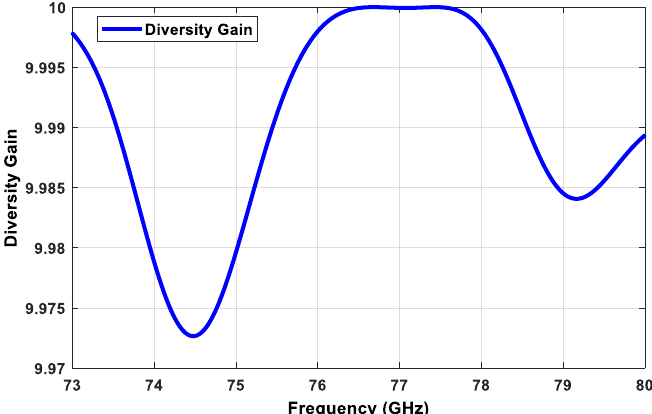
Figure 10. Simulated DG of the proposed transmitter subarray configuration .